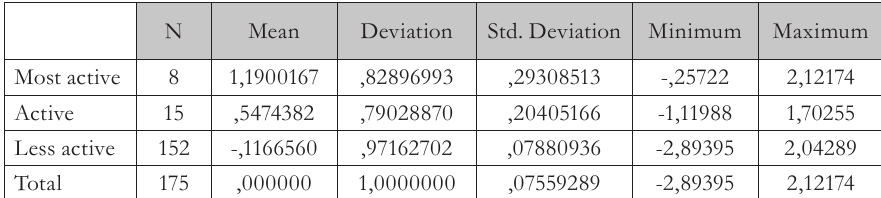
Tab. 1 - Activity and Competitiveness of the Hotel Industry in Hungary by micro-regions Source: results, own research N Mean Std.